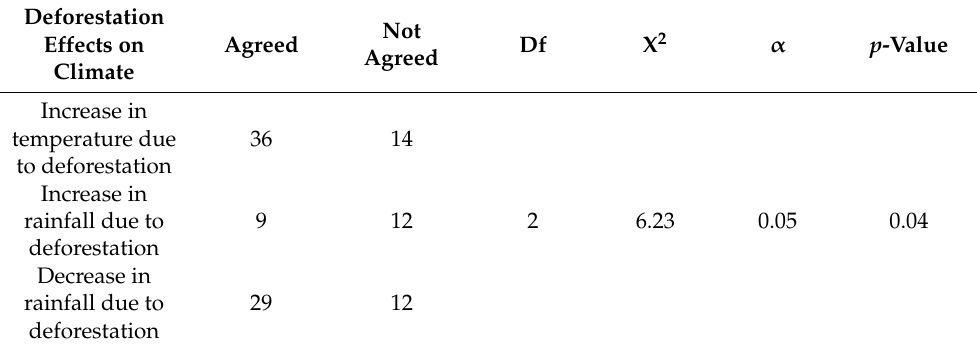
Table 15. Deforestation effects on